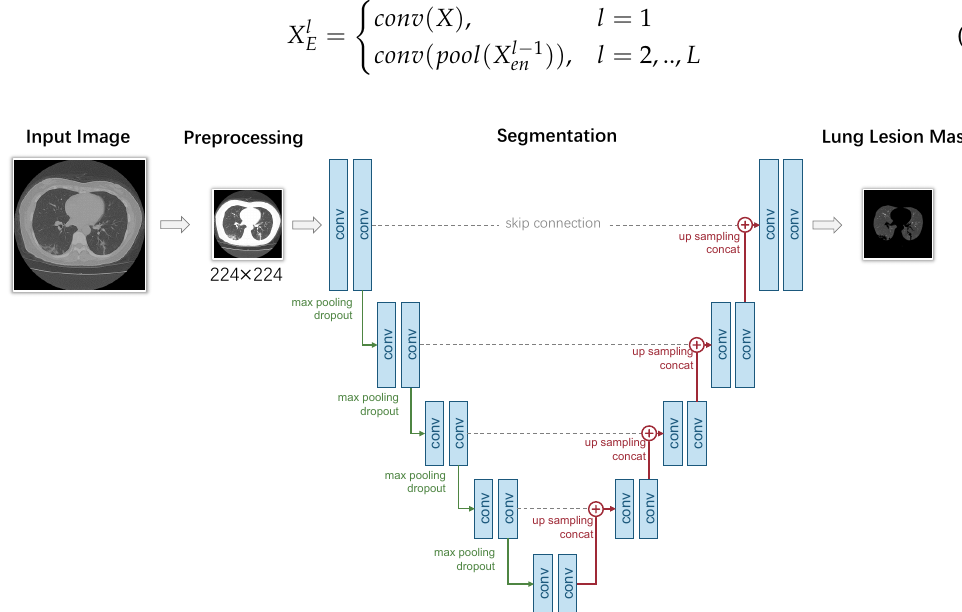
Figure 7. A typical UNet-segmentation-based pixel-level COVID-19 diagnosis